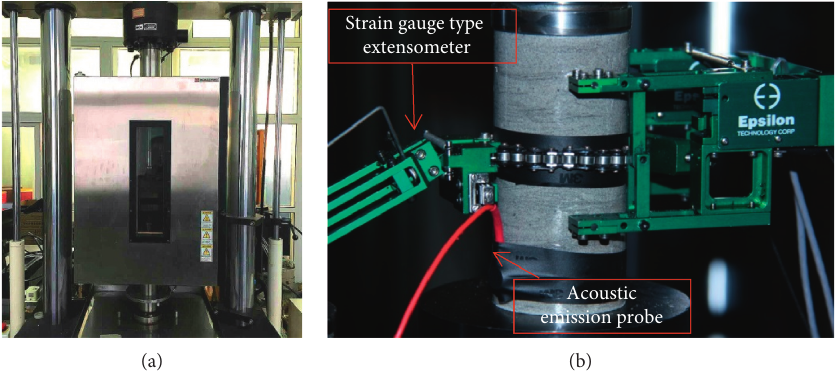
Figure 4: The XTR01 rock triaxial experimental system. (a) Microcomputer servo control triaxial testing machine. (b) Installation of strain gauge-type extensometer and acoustic emission probe.